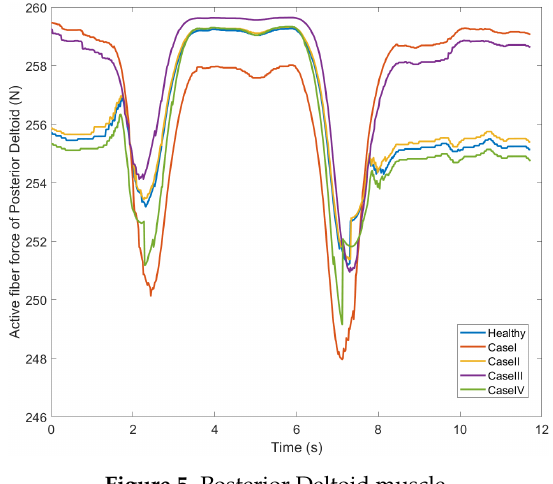
Figure 5. Posterior Deltoid muscle.